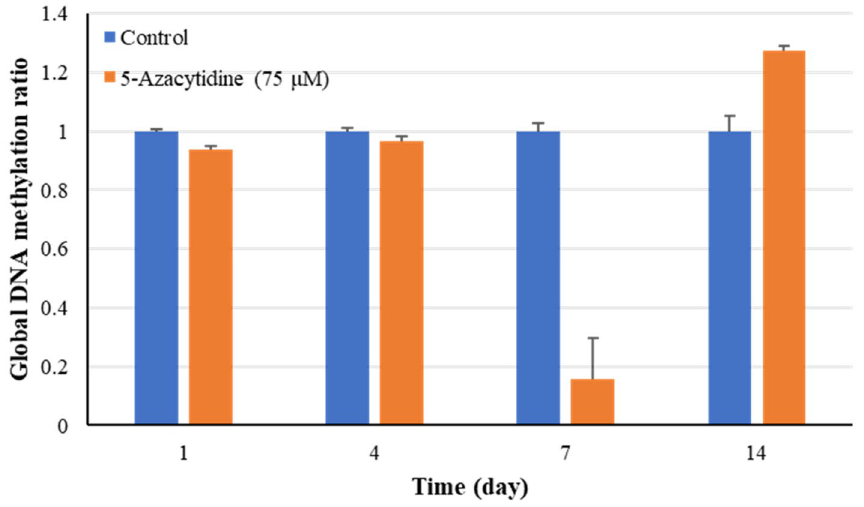
Figure 5. The ratio of global DNA methylation in Salvia miltiorrhiza hairy roots at 1, 4, 7, and 14 days with or without 75 μM 5-azacytidine treatment. The values are the mean of at least three replicates ± S.E.